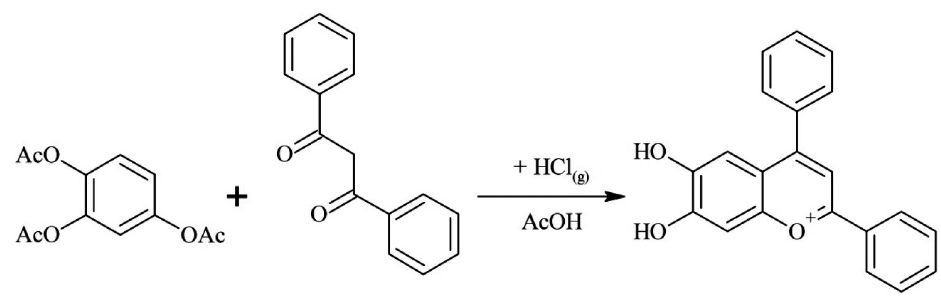
Fig. 1. Synthesis of DHDPhB